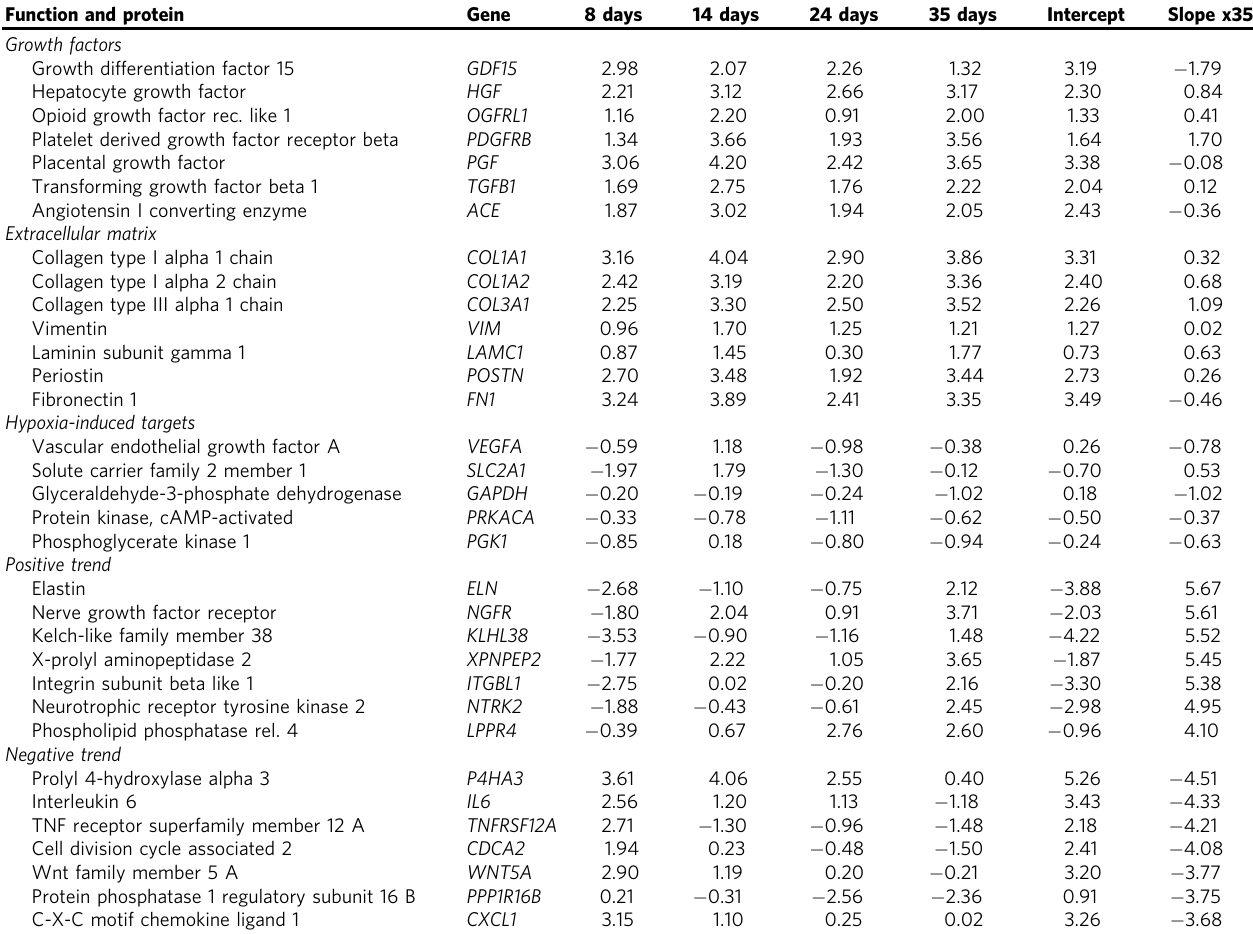
Table 2 Time course of mRNA expression in cultured myocardium Function and